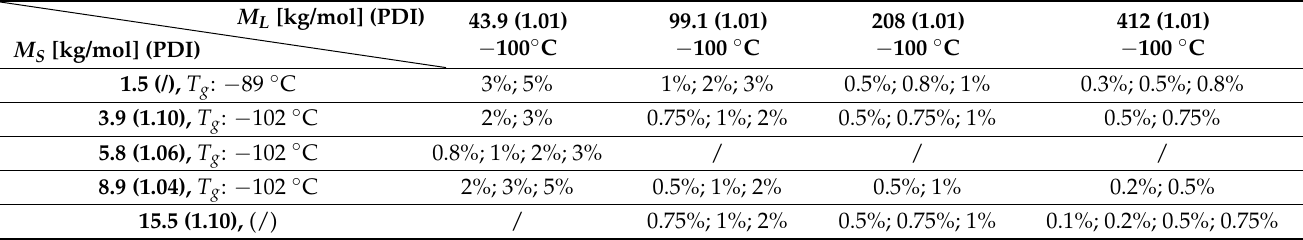
Table 6. Bidisperse PBD samples from Ref.